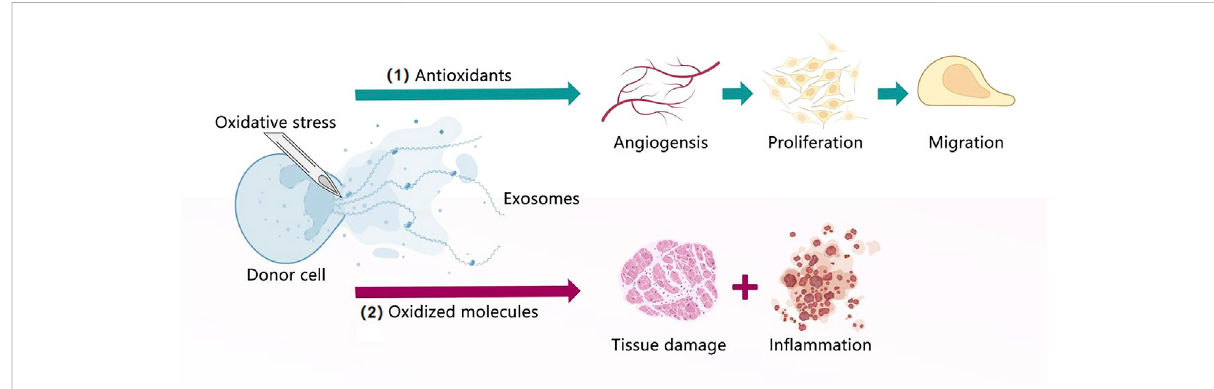
FIGURE 5 Exosomes under oxidative stress. (1) Exosomes extracted from donor cells cultured under oxidative stress contain antioxidants that can promote angiogenesis, proliferation, and migration. (2) Exosomes extracted from donor cells cultured under oxidative stress contain oxidized molecules that lead to tissue damage and in fl ammation.